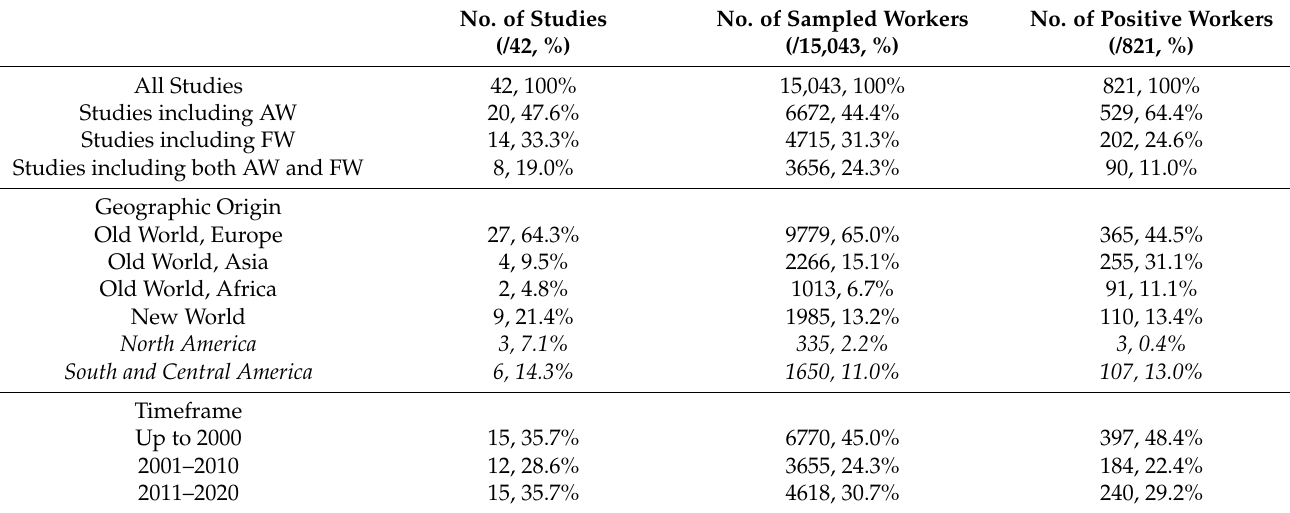
Table 2. Summary of the occupational populations included in the study. Notes: AW = agricultural worker; FW = forestry